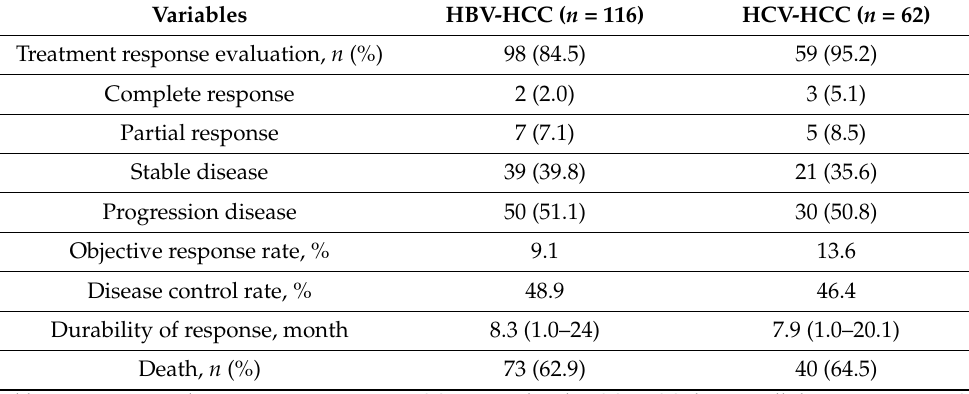
Table 2. Treatment response of HCC patients with sorafenib.